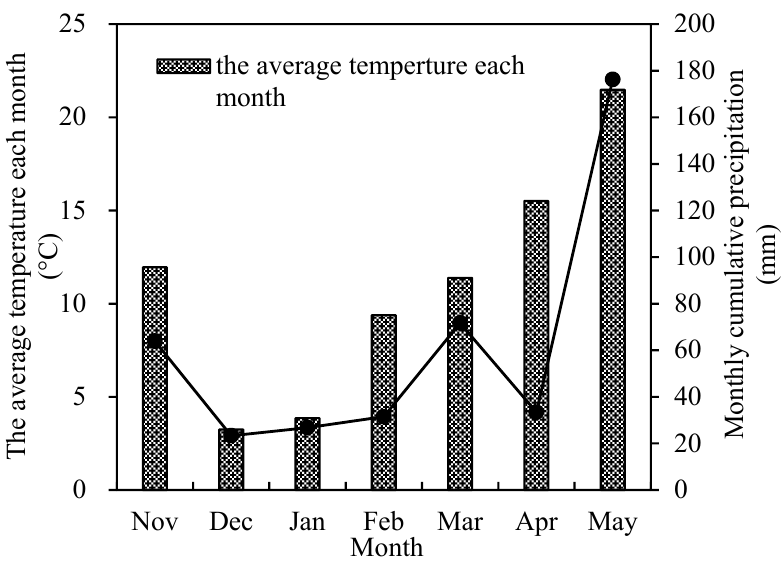
Figure 1. The precipitation (mm) and daily average temperature ( ◦ C) of wheat growth period between 2020 and 2021.